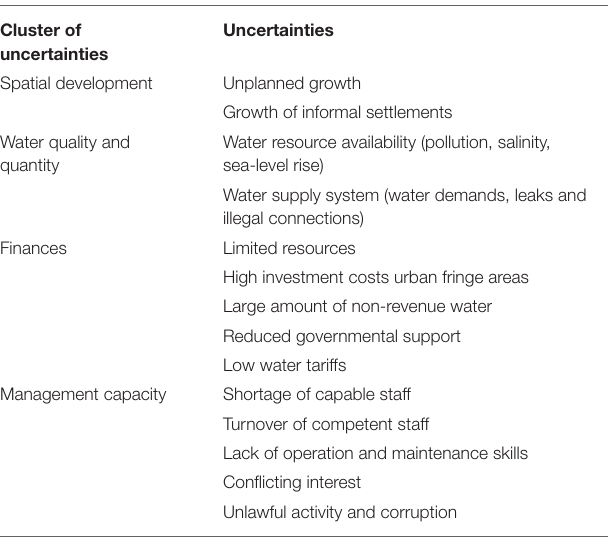
TABLE 1 | Uncertainties identified by experts during the adaptive planning workshop. Relevant uncertainties affecting the intervention chain